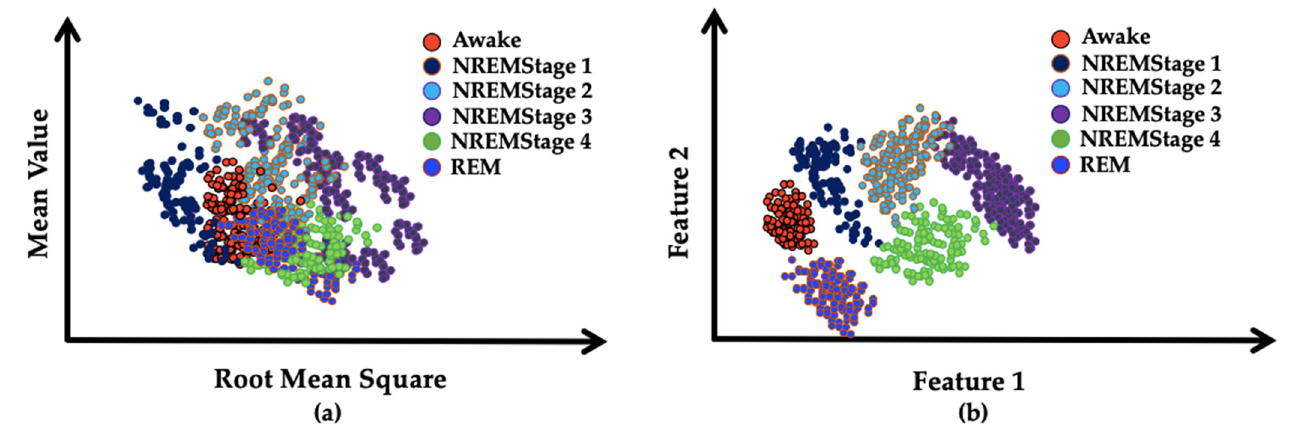
Figure 5. ( a ) Distribution of statistical features without passing though stacked autoencoder-based deep neural network, ( b ) abstract features learned by stacked autoencoders for different classes.